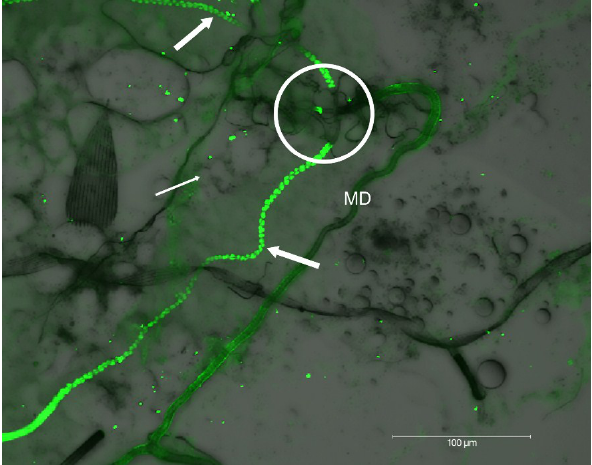
Figure 3. DIC microscopic analysis of HSPG immunolocalization to internal ducts of SG’s dissected from Ae. albopictus . Note distinct labeling of HSPG to LL’s internal ducts (thick arrows), absence of detection in ML (thin arrow), the abrupt absence of HSPG at the triad structure (circle), and the lack of detectable HSPG in the external SG main ducts